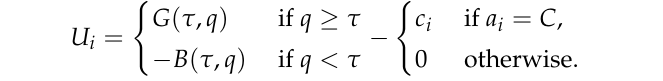
v j = q − v i be the total contributions, + \{ i }